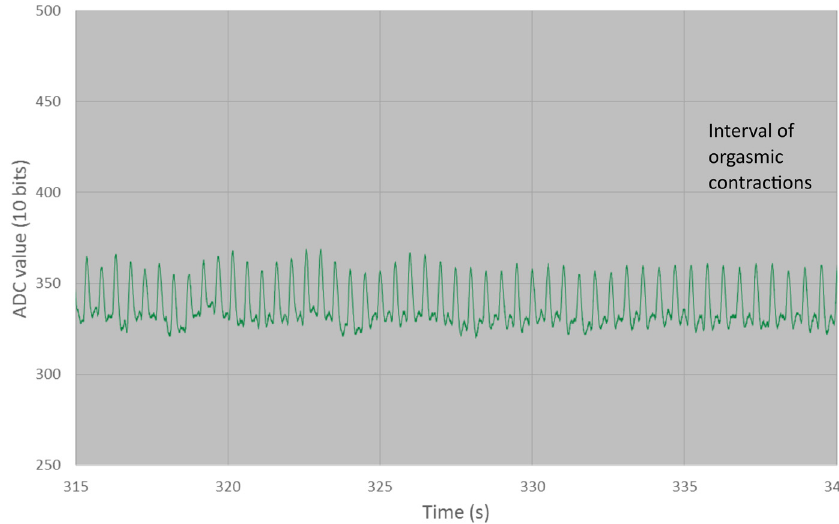
Figure 30: Detailed view of pulse amplitude.